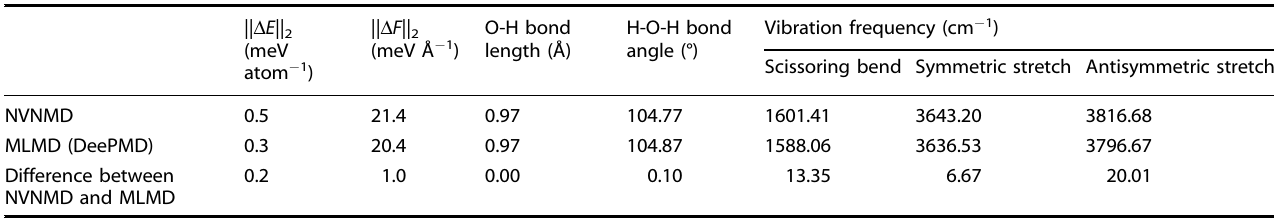
Table 4. The test error || Δ E || 2 and || Δ F || 2 , bond length, bond angle, and vibration frequencies of a single water molecule.